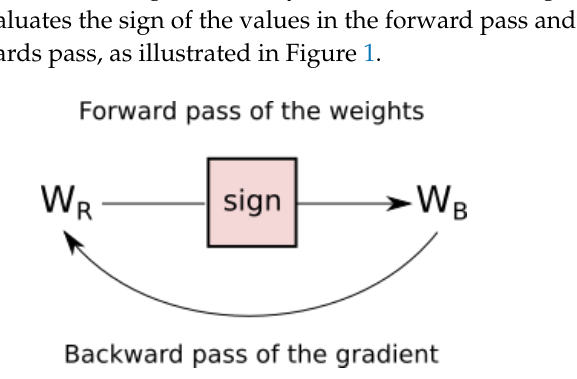
Figure 1. A visualization of the sign layer and Straight-Through Estimator (STE). While the real values of the weights are processed by the sign function in the forward pass, the gradient of the binary weights are simply passed through to the real valued